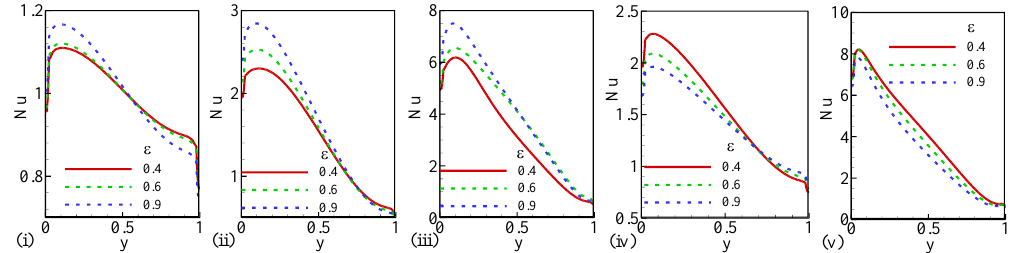
Fig. 8(b). Influence of porosity parameters on Nu , of vertical porous layer at (i) Ra =10 3 , Da =10 -2 , (ii) Ra =10 4 , Da =10 -2 . (iii) Ra =10 5 , Da =10 -2 , (iv) Ra =10 5 , Da =10 -4 and (v) Ra =10 6 , Da =10 -4